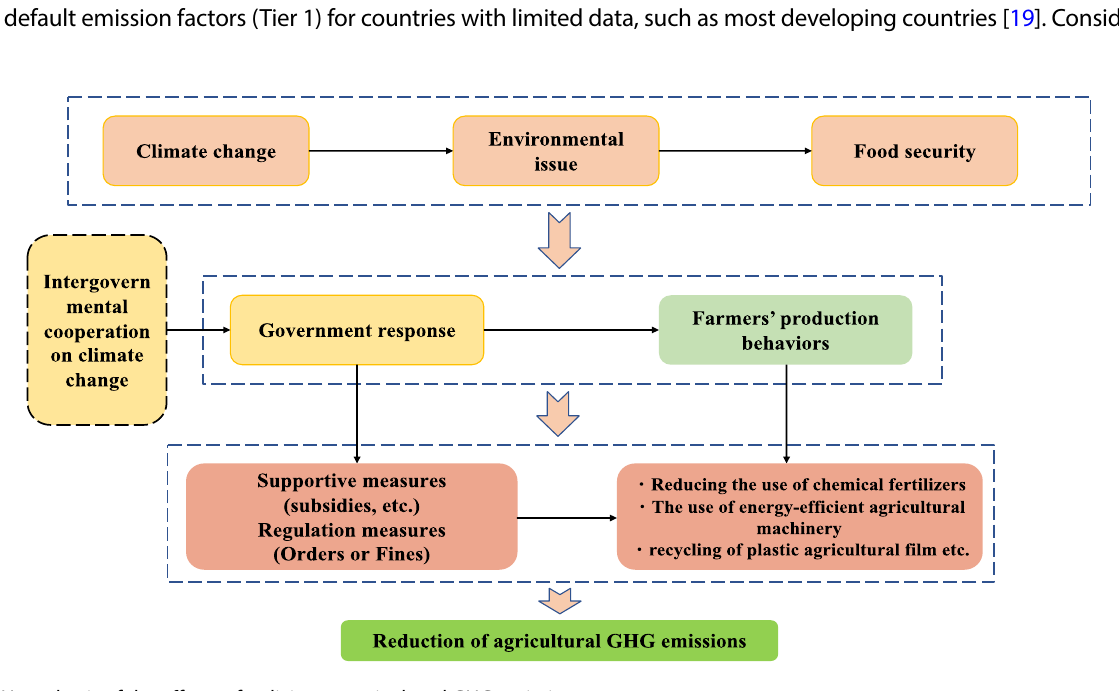
Fig. 3 Hypothesis of the effects of policies on agricultural GHG